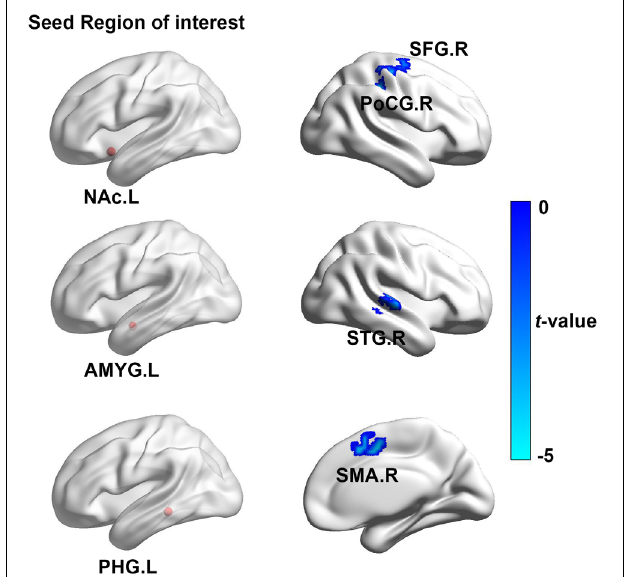
FIGURE 2 | The brain regions show significant difference of the limbic-FC between ISSNHL patients and healthy controls. Left brain diagram shows the seed region of interesting of limbic system, right brain graph presents the regions with significant group-difference. FC, functional connectivity; STG, superior temporal gyrus; PoCG, postcentral gyrus; NAc, nucleus accumbens; SFG, Superior frontal gyrus; AMYG, amygdala; PHG, paraHippocampal gyrus; SMA, supplementary motor area; L, left hemisphere; R, right hemisphere. The color bar represents the t -value.